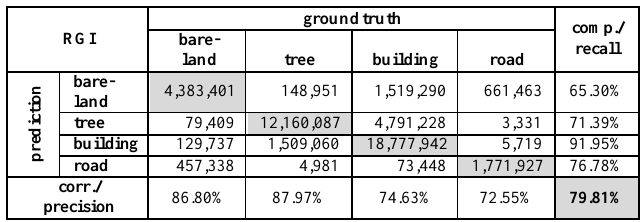
Table 4. Confusion matrix of segmentation result using RGI